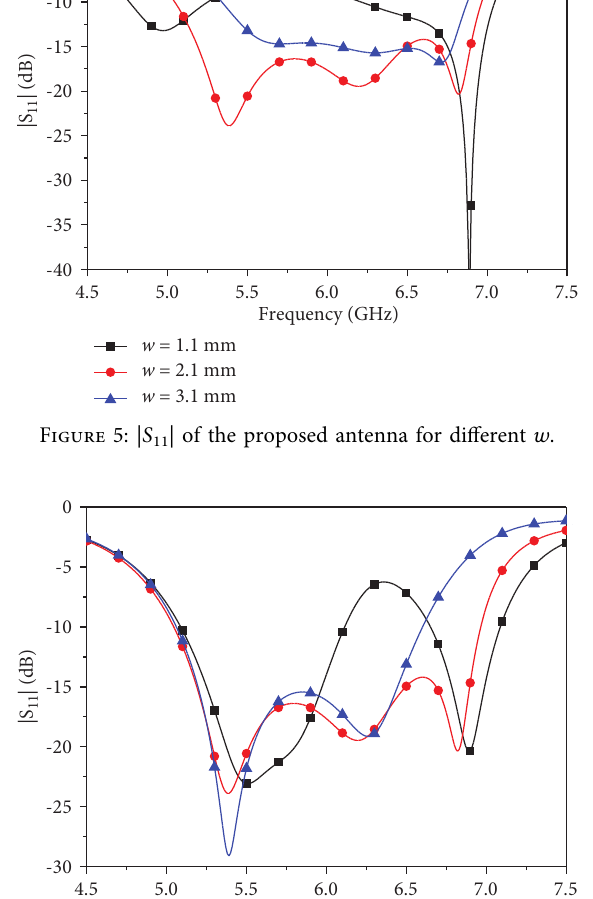
Figure 6: | S 11 | of the proposed antenna for different d .